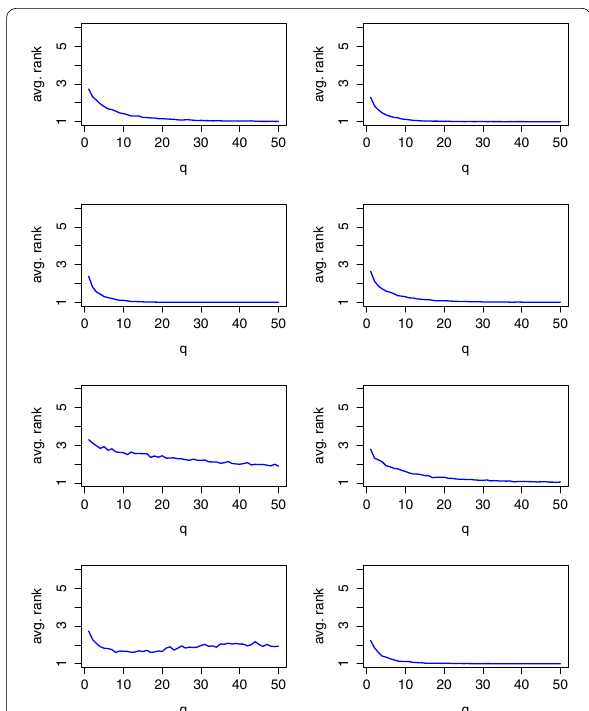
Fig. 9 Average rank of the correct PIN for Users 1, 3, 5 and 7 (left column) and Users 2, 4, 6 and 8 (right column)